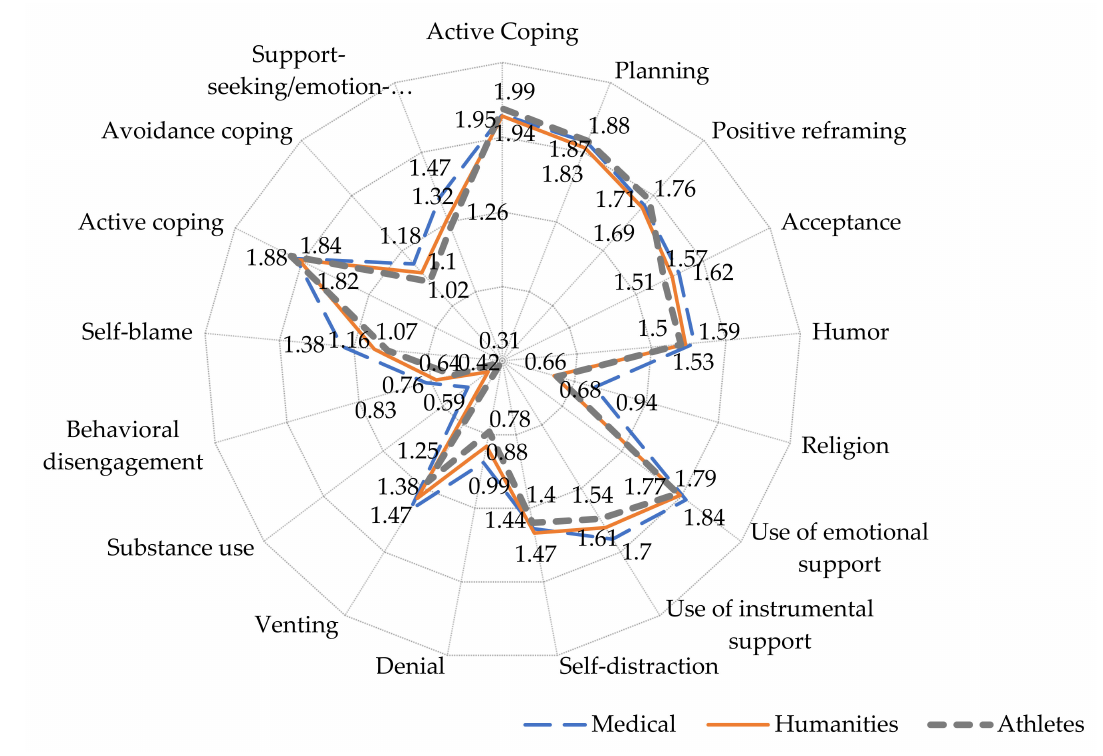
Figure 2. Manifestations of coping strategies among the students in the three groups.